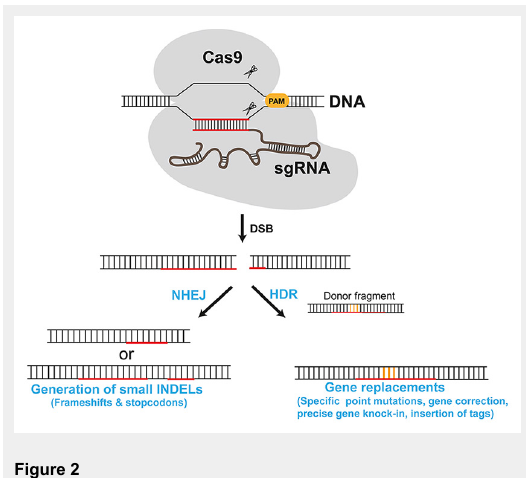
Genome editing by CRISPR-Cas9. Schematic of possible outcomes of CRISPR-Cas9-induced DSBs. Repairing via non- homologous end joining (NHEJ) generates indels, while repair via homologous recombination in the presence of an appropriate donor fragment can be used to introduce specific genetic changes (in orange). The sequence recognized by the sgRNA is in red. The location of the protospacer adjavent motif (PAM) in the target site is also